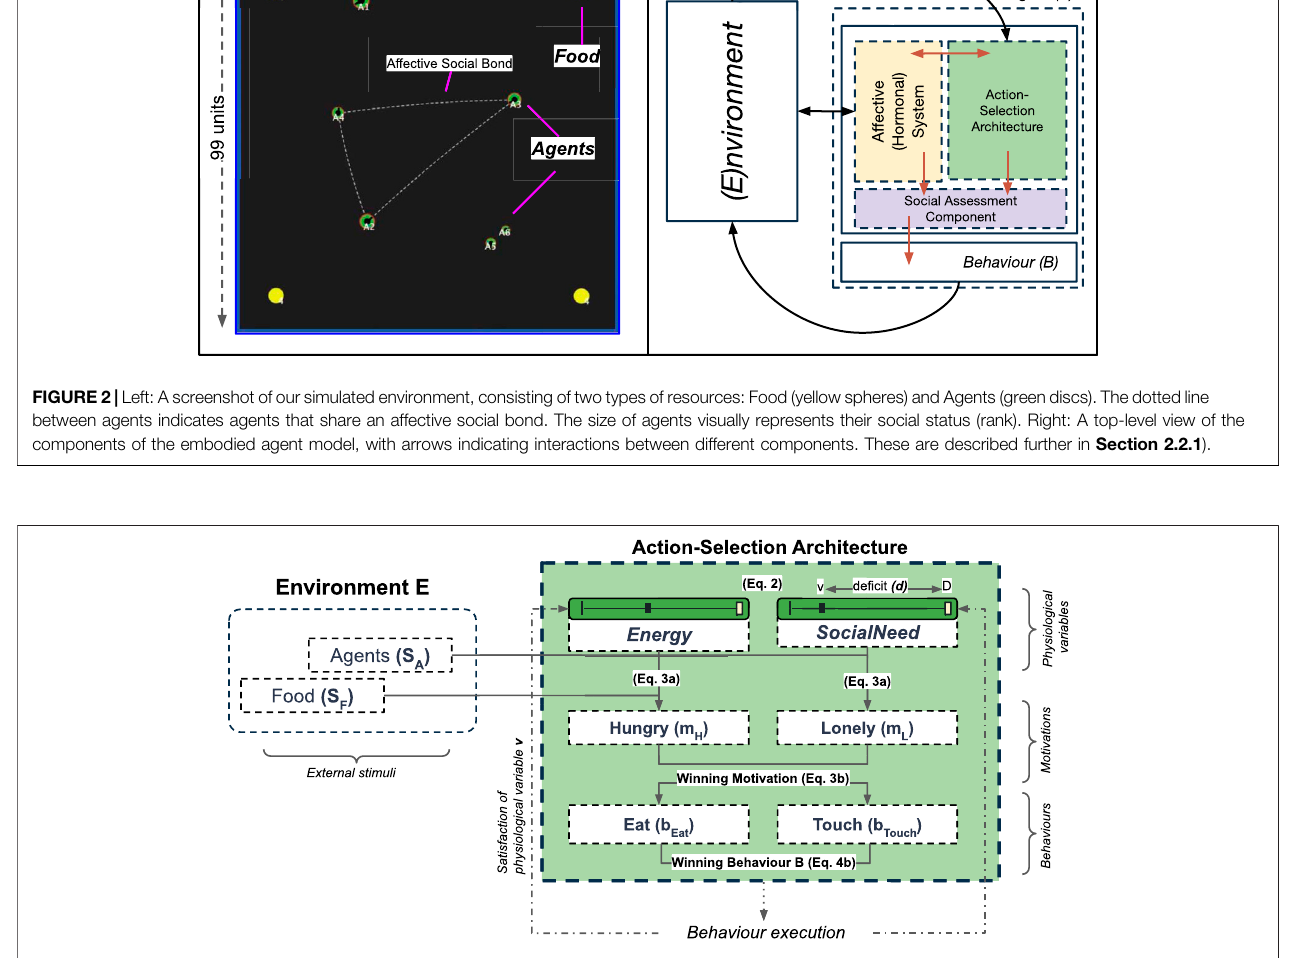
FIGURE3| AnoverviewoftheAction-SelectionArchitecturewhichselectsbehaviourstoregulatethetwointernal(physiological)variables Energy and SocialNeed . Numbers in parenthesis correspond to relevant equations in this section. Further details are provided in Table 1 .